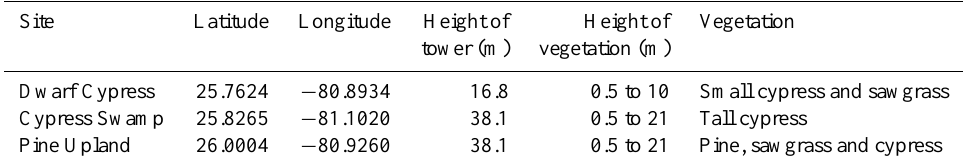
Table 1. Site locations, tower heights and summary of